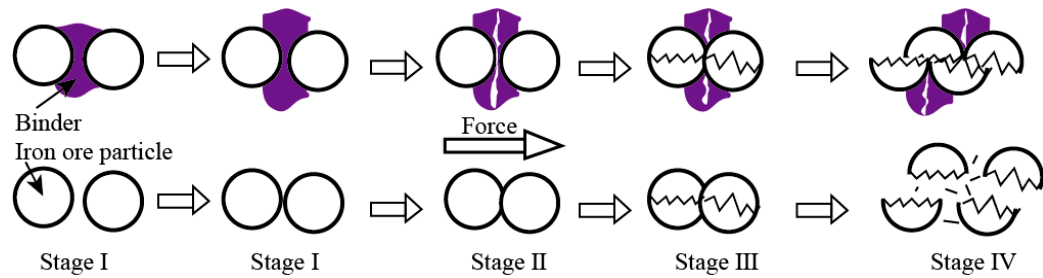
Figure 10. Typical compressive strength curve of CBB with dry ( a ) and heat-treated ( b ) at 500 ◦ C for 30 min conditions.